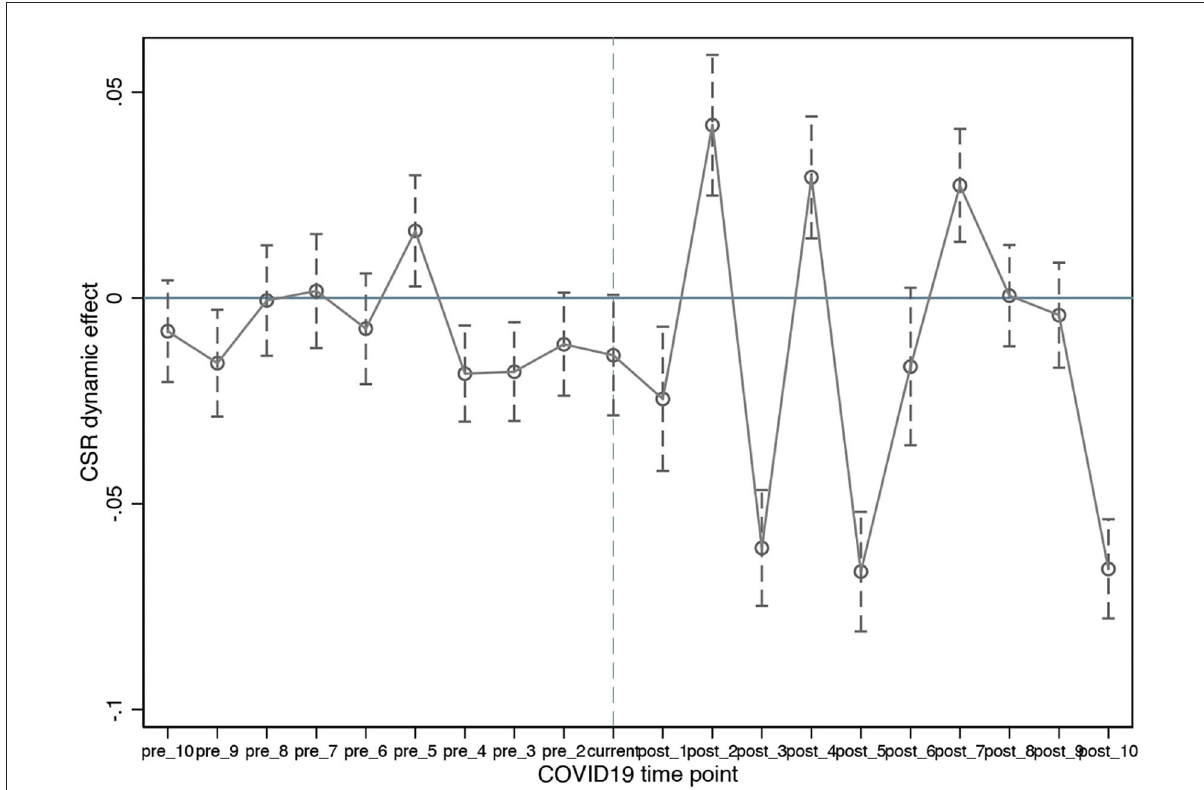
FIGURE2 The dynamic effect of CSR on stock return. The figure is based on period − 1, and the coefficients of other periods are relative values to that period. The solid points are the point estimates of the coefficients of each period, and the short vertical lines are the confidence intervals calculated using the robust standard errors of the individual-level clustering at the 95% significance